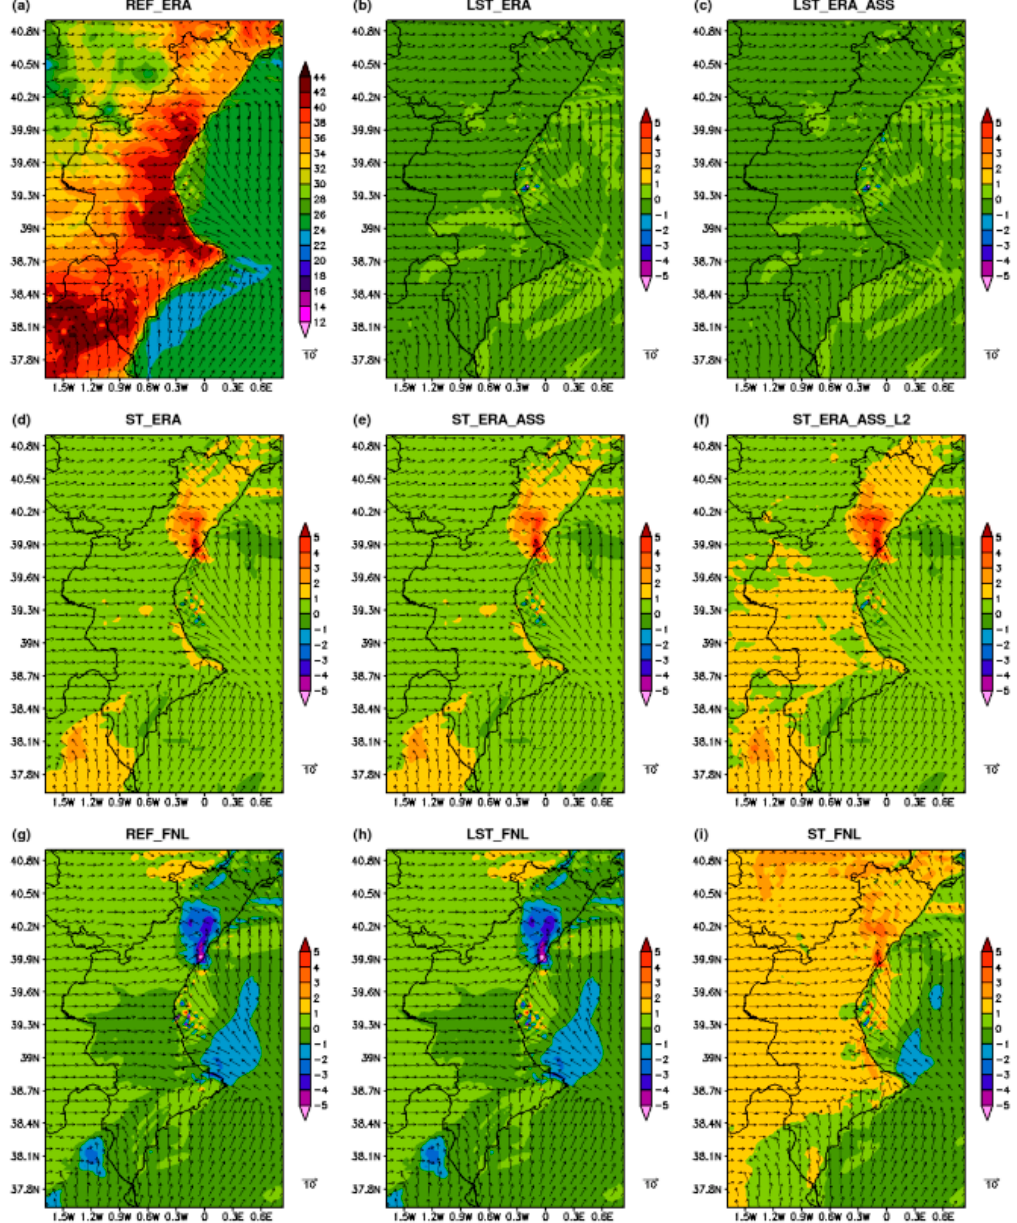
Figure 5. Same as Figure 4, but on 23 July 2009.